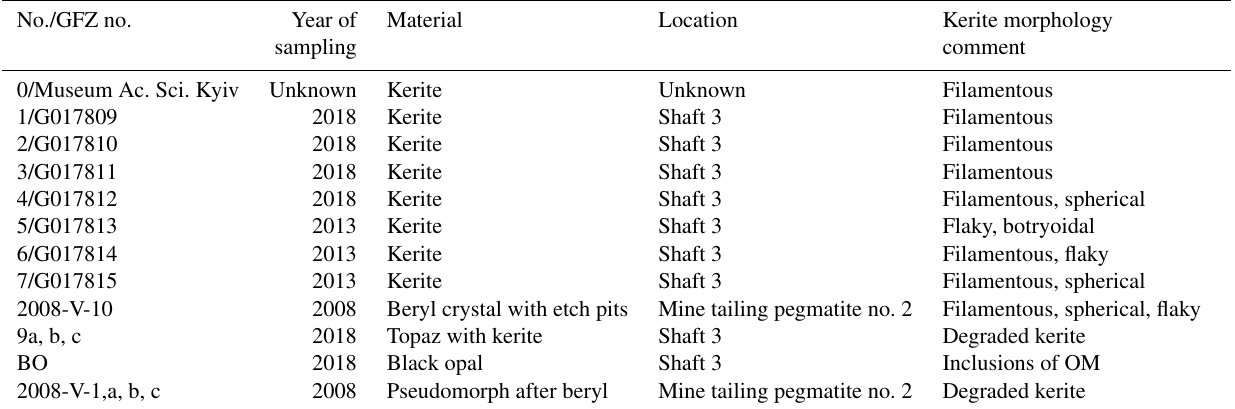
Table 1. List of samples and their macroscopic appearance. No./GFZ no. Year of Material Location Kerite morphology sampling